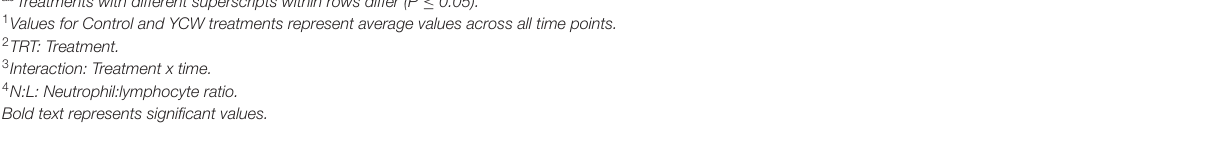
TABLE 4 | Intraperitoneal temperature, serum cortisol, glucose, and non-esterified fatty acid (NEFA) concentrations measured in pigs fed a control (Control) diet or supplemented with a yeast cell wall at 250 mg/kg (YCW250) or 500 mg/kg (YCW500), following administration of an oral Salmonella Typhimurium challenge on d 19.